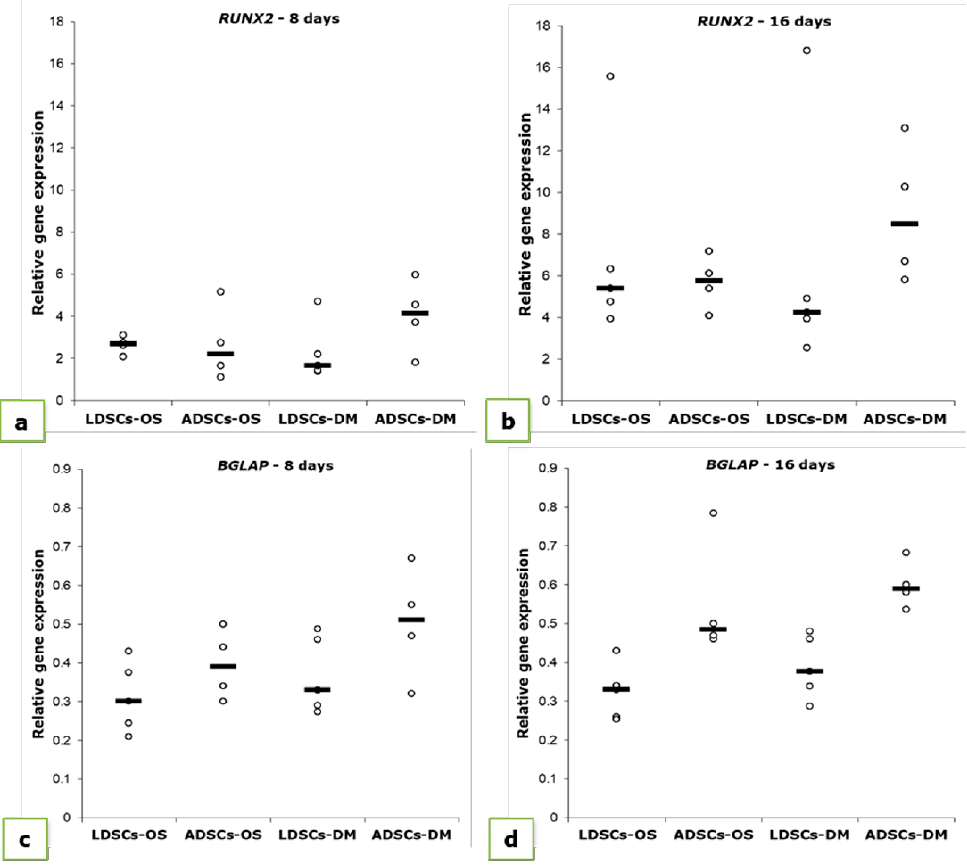
Figure 12. Relative expression levels (2 - ∆∆ Ct ) of RUNX2 ( a , b ) and BGLAP ( c , d ) measured in LDSCs and ADSCs at day 8 ( a , c ) and day 16 ( b , d ) of osteogenic differentiation and normalized to GAPDH ; scatterplots with median; n (LDSCs) = 5 and n (ADSCs) = 4 for all groups. Table 2. Relative expression of RUNX2 and BGLAP in LDSCs and ADSCs at days 8 and 16 of osteogenic differentiation, normalized to GAPDH and compared to the cells at P2 (day 0). Results are expressed as mean values ± SD. Asterisks represent statistical significance compared to P2 (day 0). RUNX2 Cell type